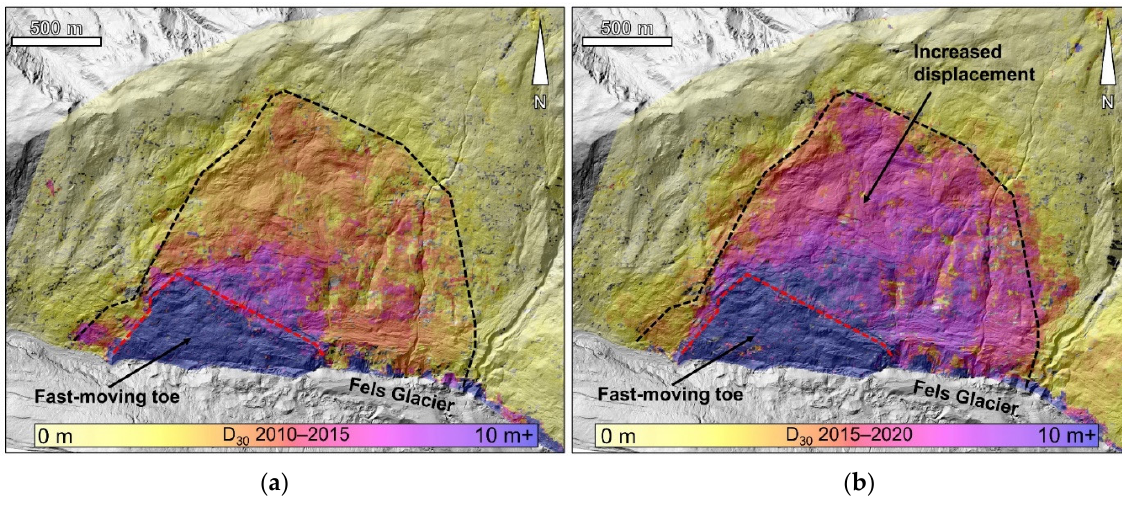
Figure 5. Rasters of the computed displacement magnitude overlain on the 2016 ALS hillshade base map (courtesy of Alyeska Pipeline Service Company). ( a ) 3D displacement computed in the 2010–2015 time window. ( b ) 3D displacement magnitude computed in the 2015–2020 time window. Note the higher displacements in the 2015–2020 time window compared to the 2010–2015 time window. The black dashed line outlines the inferred extent of the Fels landslide. The red dashed line outlines the fast-moving slope toe, where the magnitude of 3D displacement exceeds 20 m for both the 2010–2015 and 2015–2020 time